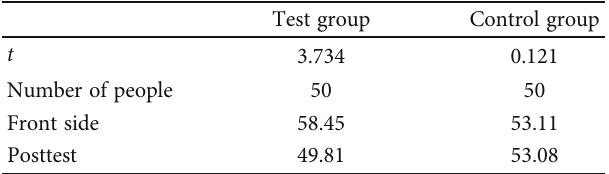
Figure 4: Coping style of the experimental group and the weight of each factor of SCL-90. Table 2: Comparison of the results of the SAS anxiety self-rating scale between the experimental group and the control group before and after the intervention.